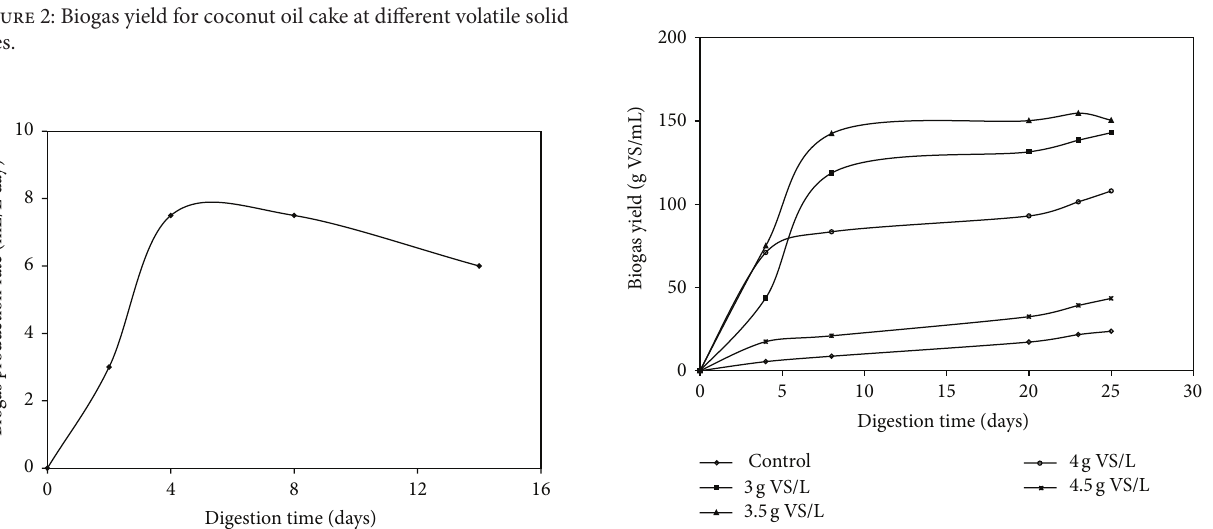
Figure 5: Biogas yield mL/g VS for cashew apple